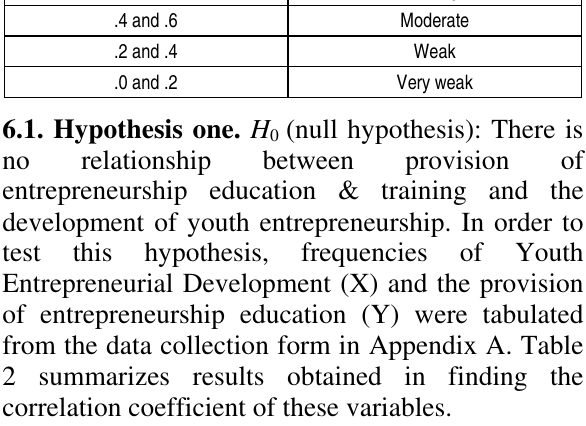
Table 2. Correlation between the provision of entrepreneurship education & training and